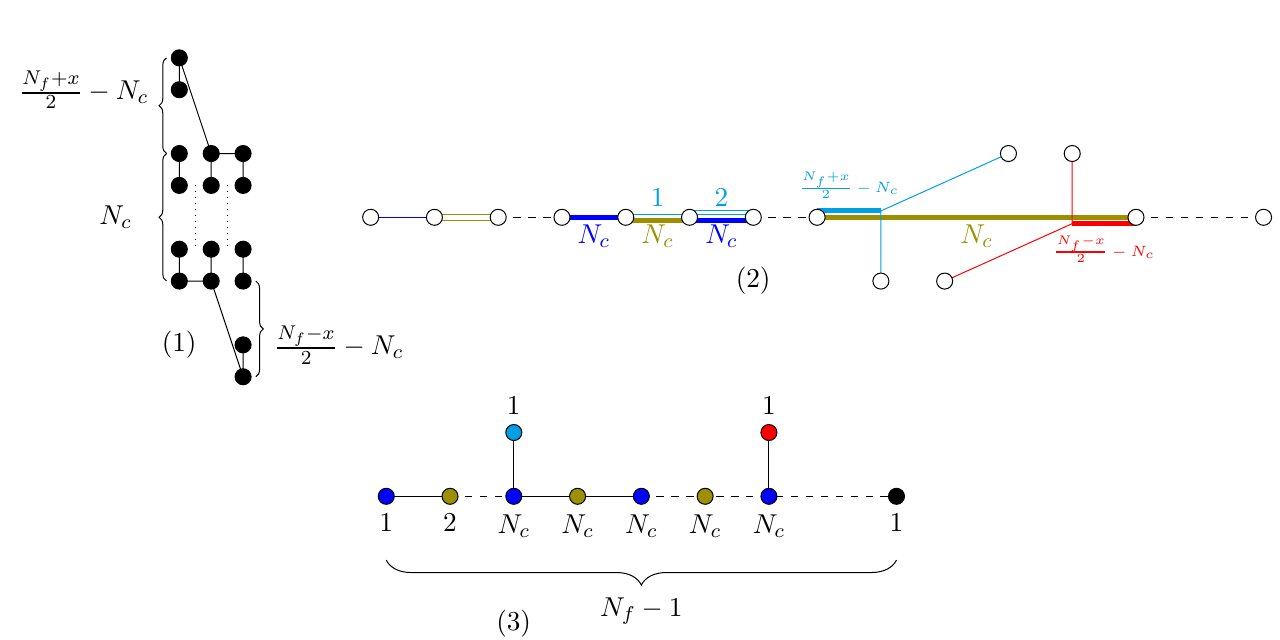
Figure 20 . (1) Toric Diagram representing SQCD with N f > 2 N c + 2 at finite gauge coupling where masses are set to zero. (2) Brane Web indicating the Higgs Branch (3) magnetic Quiver whose 3d Coulomb Branch is the Higgs Branch of our SQCD. In this figure, x = 0 if N f even, and x = 1 if N f odd. The black node in the quiver is not displayed in the brane web. The quiver is symmetric. Note that the grid diagram is not convex and we cannot obtain the brane web construction for the infinite coupling regime by contracting it in the horizontal direction even if a UV fixed point